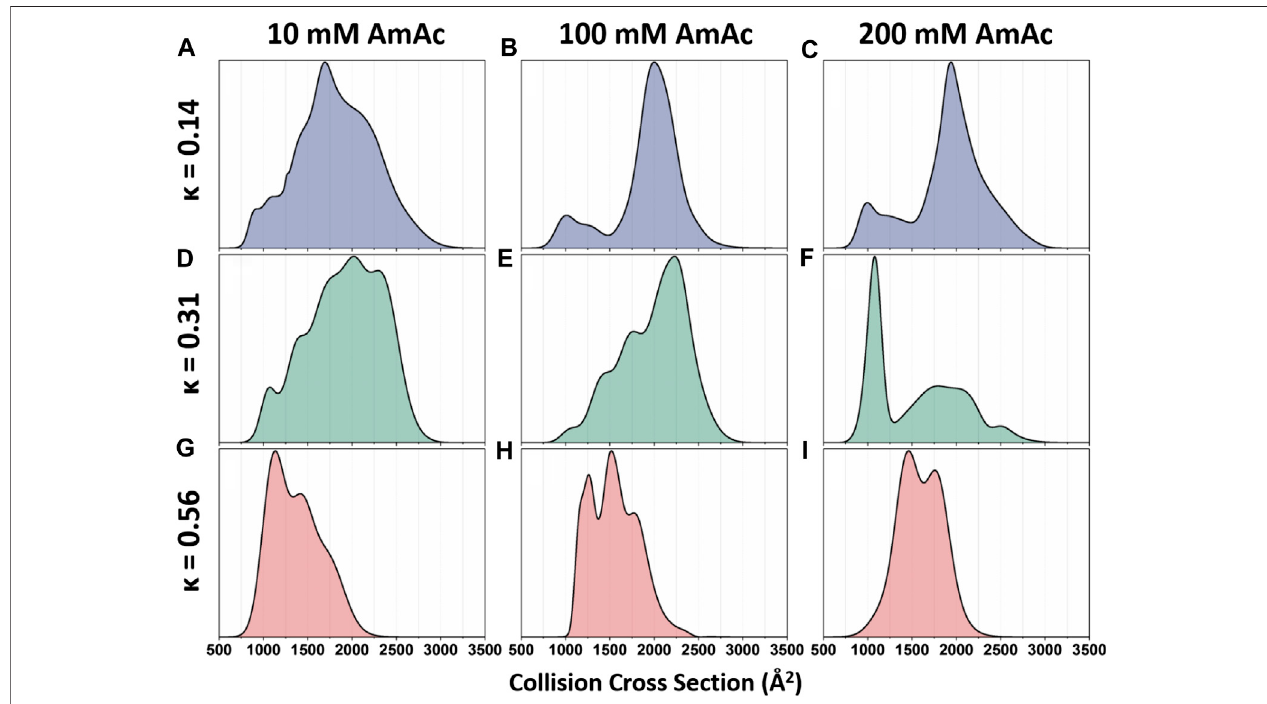
FIGURE3| Global collisioncross-sectiondistributions ofallthreep27 permutants sprayedfrom10 mM, 100 mM, or200 mM ammonium acetate.Globalcollision cross-section distributions are shown for the (A – C) p27 C - κ 14 (blue), (D – F) p27 C -WT (green), and (G – I) p27 C - κ 56 (red) permutants. Global CCSDs are obtained by combining CCSDs of individual charge states into single feature-rich distributions. Oppositely charged residues are well mixed in sequences with low κ values, whereas oppositely charged residues are segregated in sequences with high κ values (Das and Pappu 2013). Figure adapted from (Beveridge et al., 2019a).